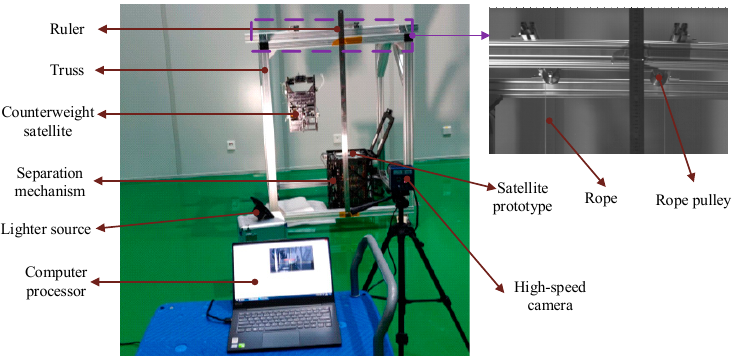
Figure 18. Gravity compensation system.